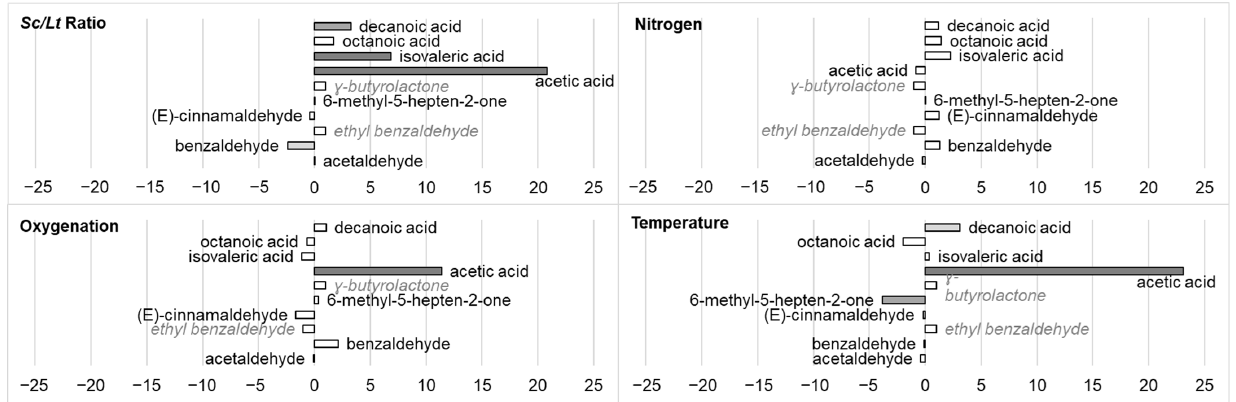
Figure 5. Impact (standardized effects) of fermentation parameters ( Sc / Lt ratio, nitrogen, oxygenation, temperature) on the production of different volatile compounds (aldehydes, ketones, acids). Data are identified as statistically almost significant (0.05 < p -value < 0.1, light grey), significant ( p -value < 0.05, grey), or very significant ( p -value < 0.01, dark grey). Compounds in italics and in grey were only present in trace amounts, with values too low to perform a relevant statistical test.